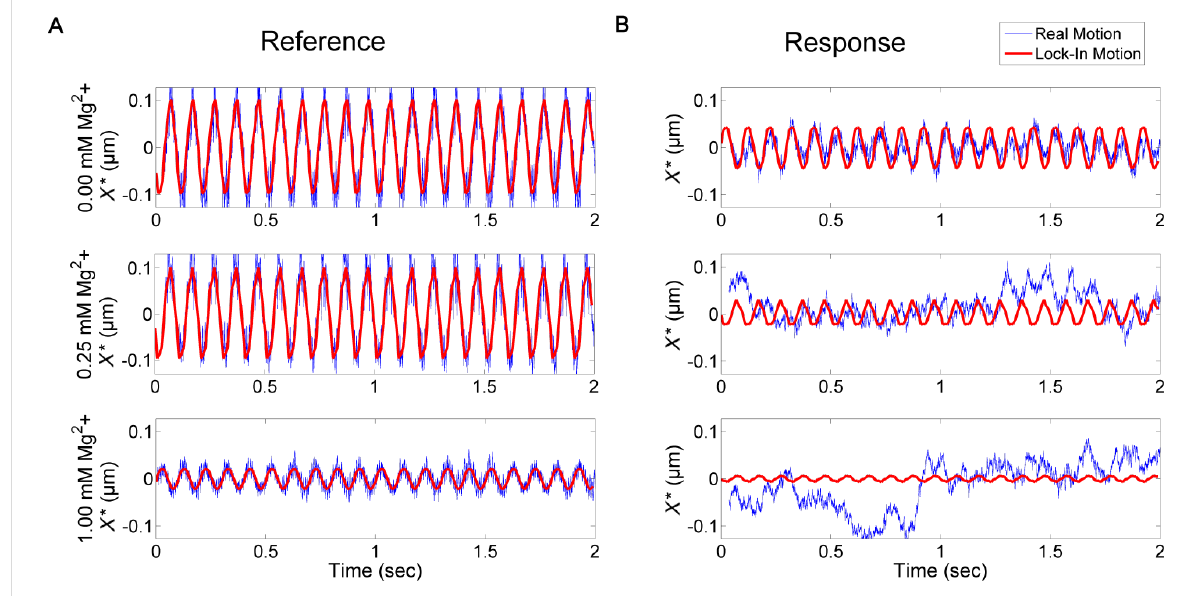
Figure 2: Motion of particles in networks due to the excitation of the oscillating optical trap ( A = 0.127 µm). The red line denotes the calculated motion via the lock-in method whereas the blue line is the recorded motion. A) Response motion of the reference particle depending on the amount of added crosslinker (laser beam oscillating in the same direction with equal strength). The amplitudes decrease due to a stiffer network. B) Response motion of particles with a distance of 3 µm to the reference particle, dependent on the crosslinker concentration. Since for higher concentrations of Mg 2+ the reference particle shows a smaller amplitude, the response of a neighboring particle decreases. This implies a decrease of the SNR and introduces errors. The thermal motion becomes more dominant.